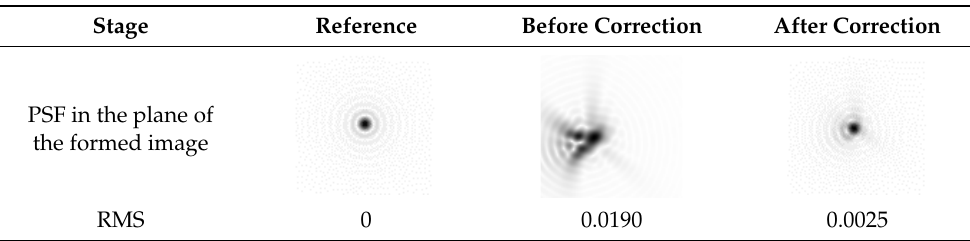
Table 4. PSF simulation on the retina before and after laser vision correction.